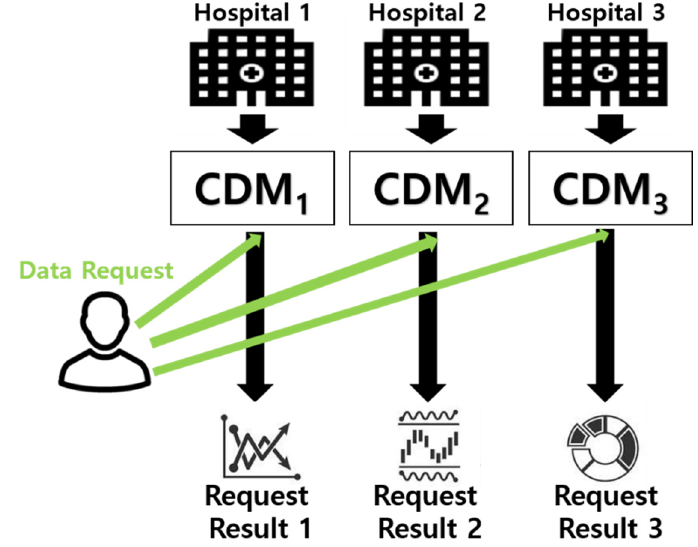
Figure 1. Conventional concept of Common Data Model (CDM) and operation scheme.